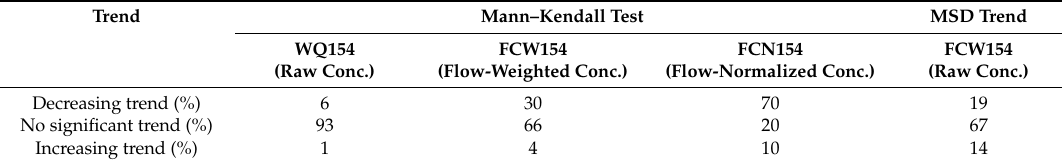
Table 5. Trend analysis of annual nitrate concentration using raw, flow-weighted and flow-normalized concentrations using the Mann–Kendall trend test for the period 2008–2015 (8 years) along with the calculated MSD trend using the raw concentration (conc.).